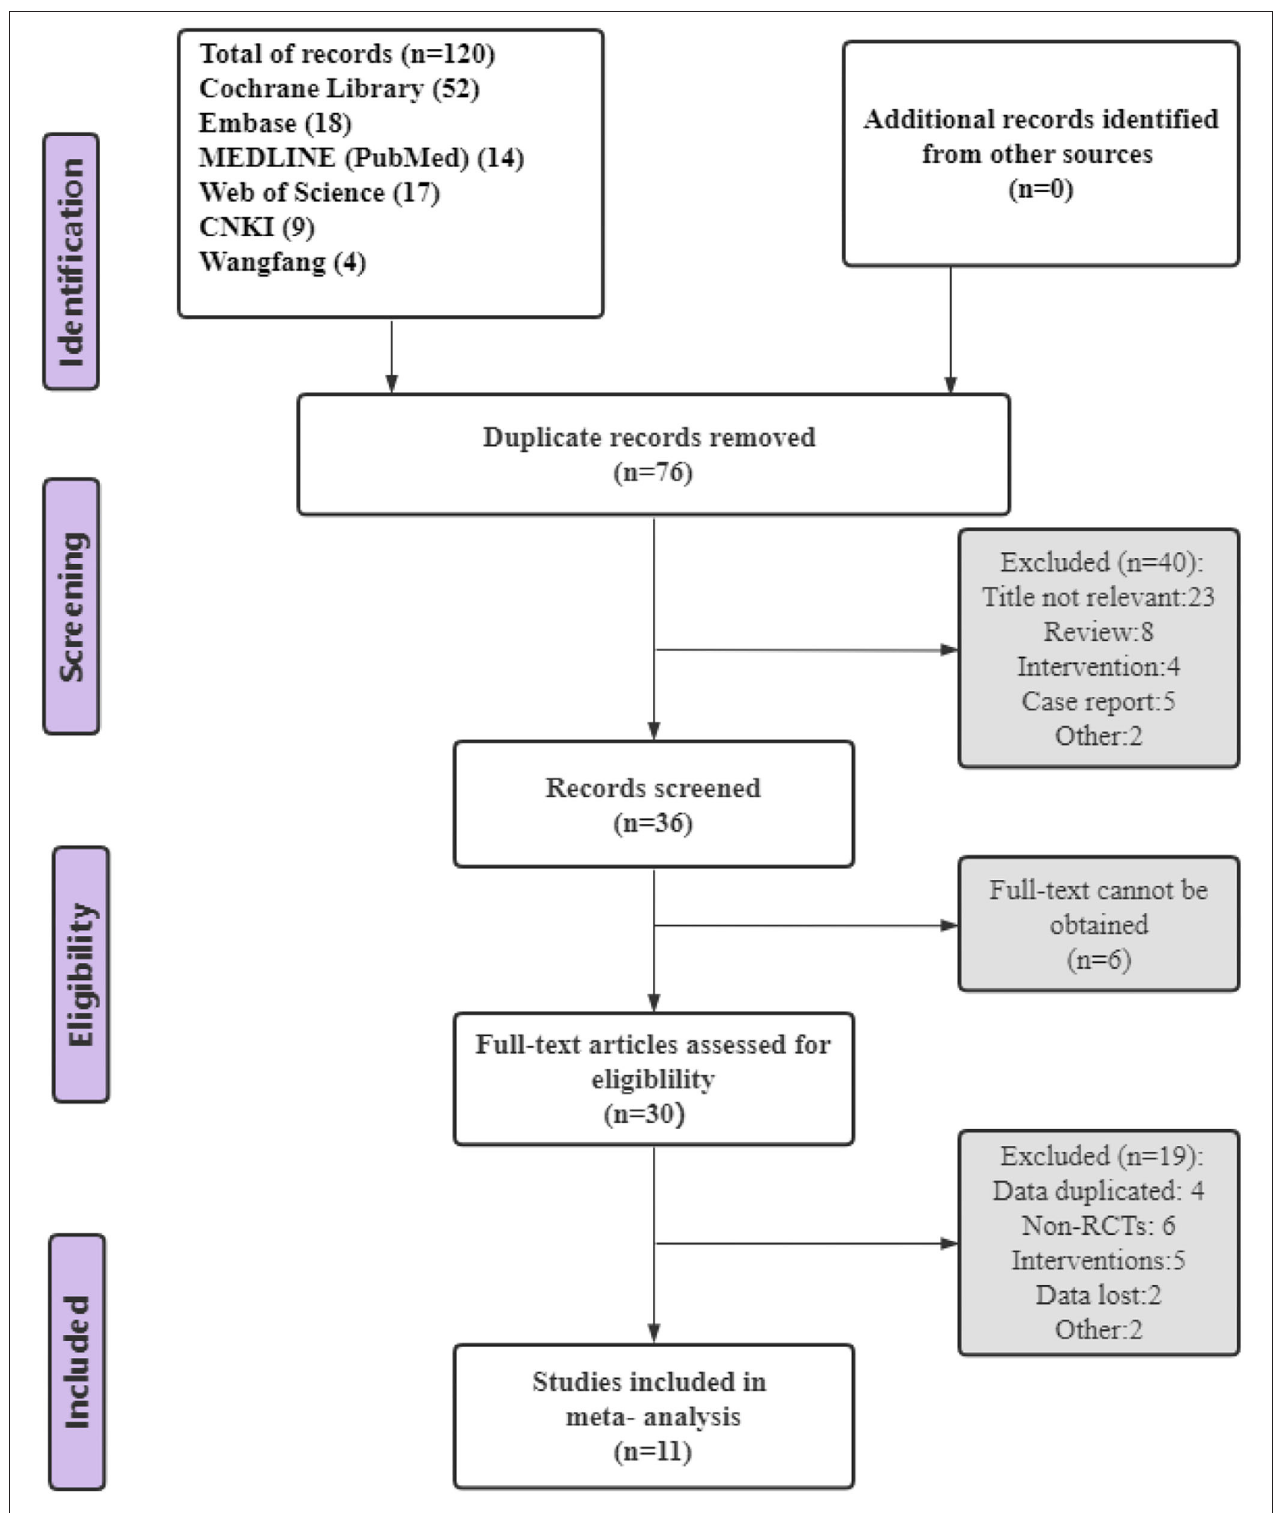
FIGURE 1 | PRISMA flow chart of study